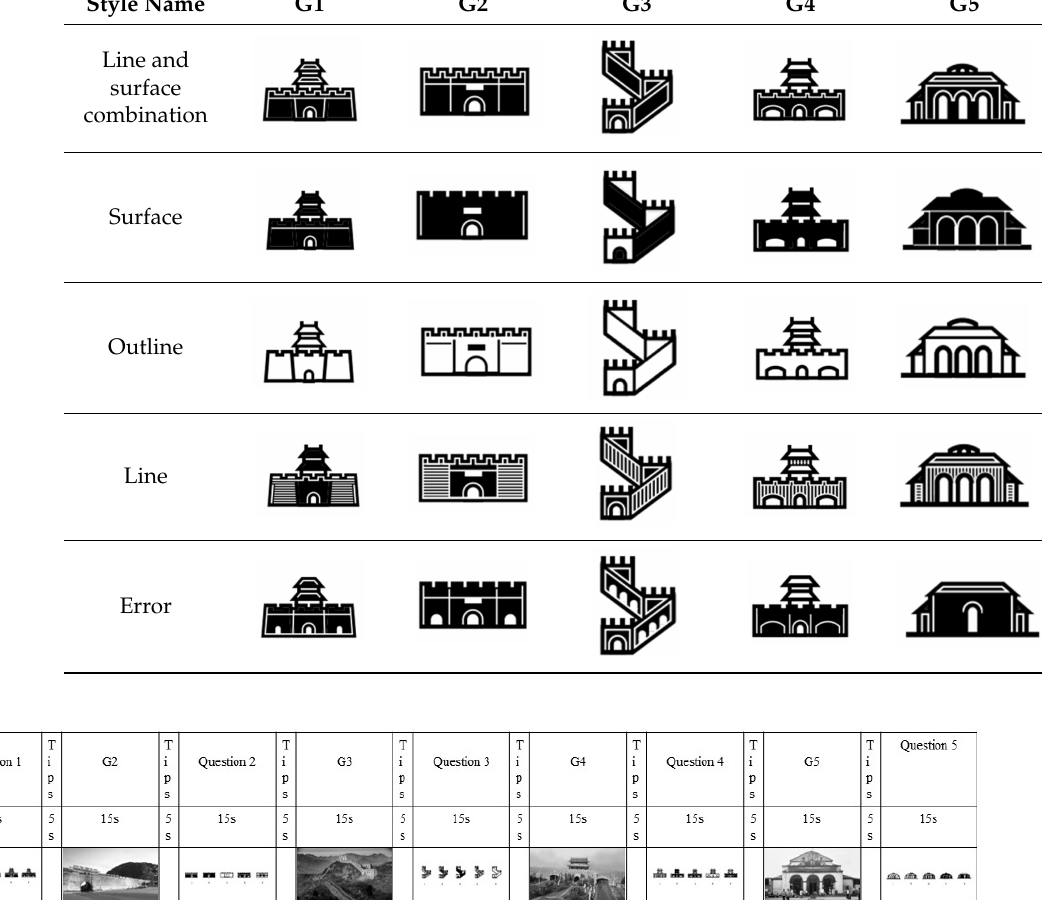
Table 2. Styles of Transliteration Symbols.